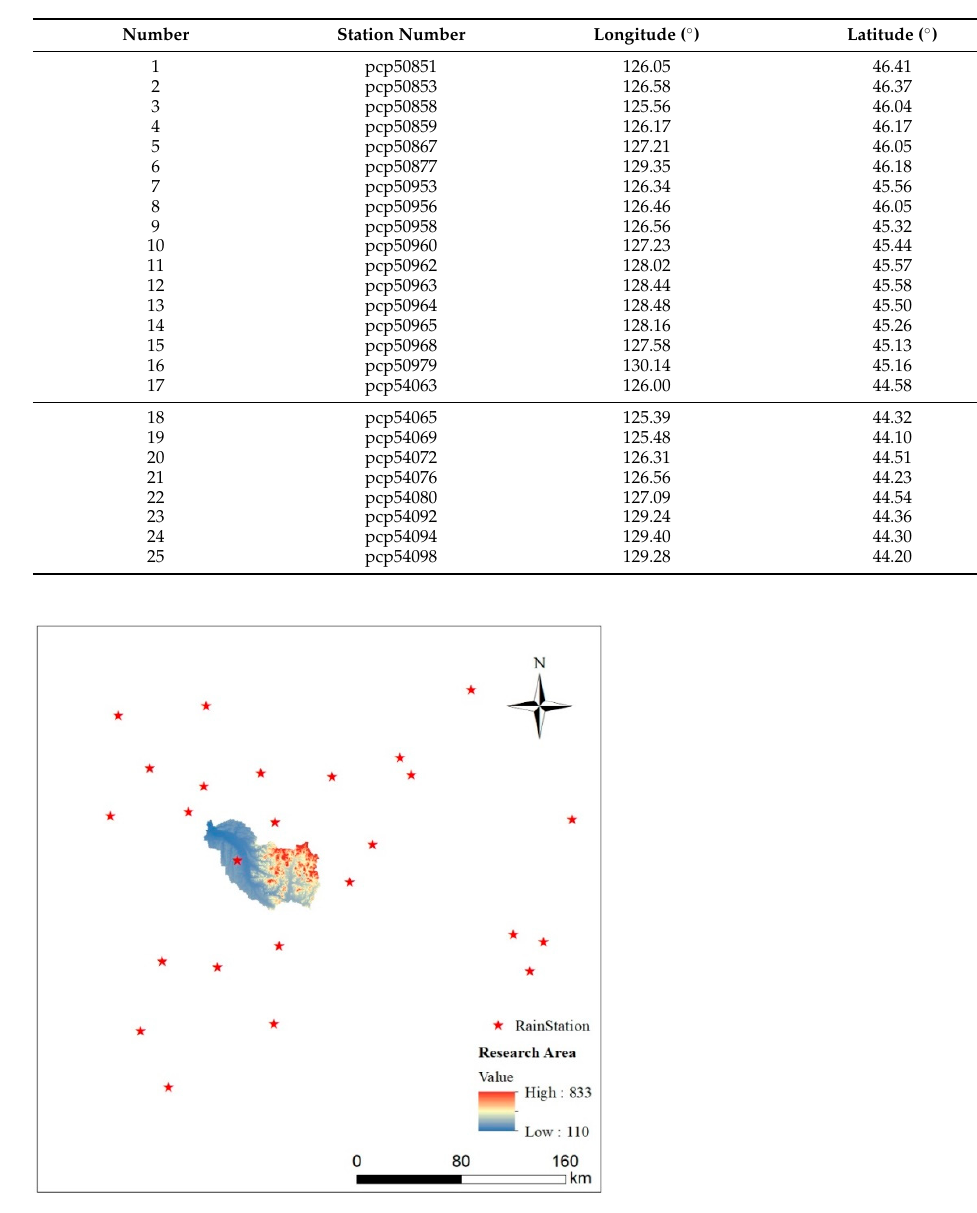
Figure 5. Location map of meteorological stations.